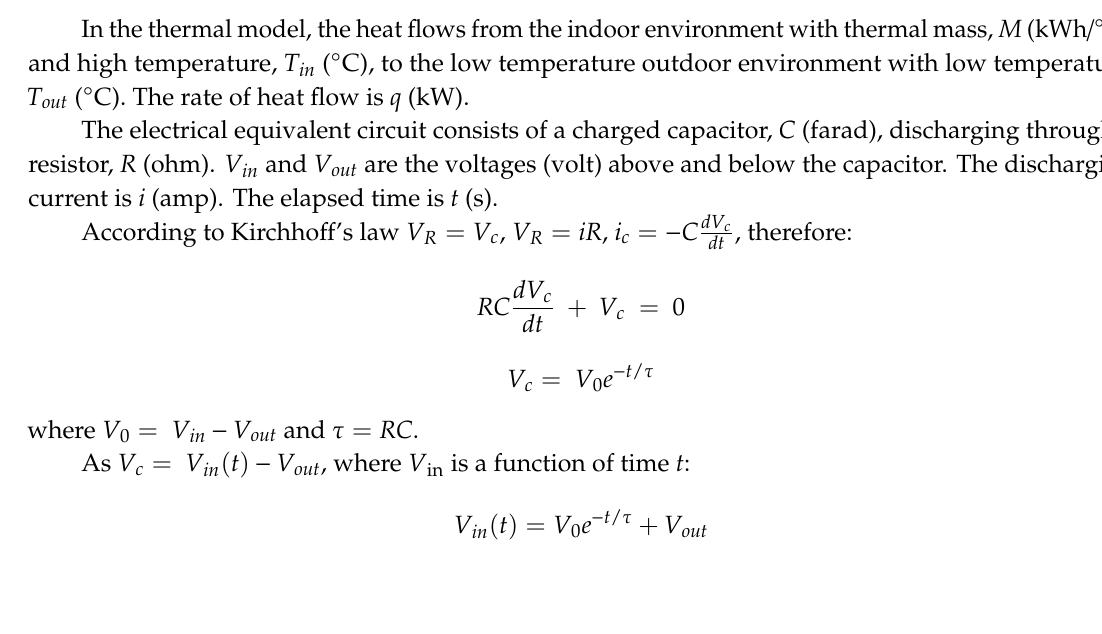
Figure 1. ( a ) Indoor thermal model; ( b ) Electrical equivalent model.